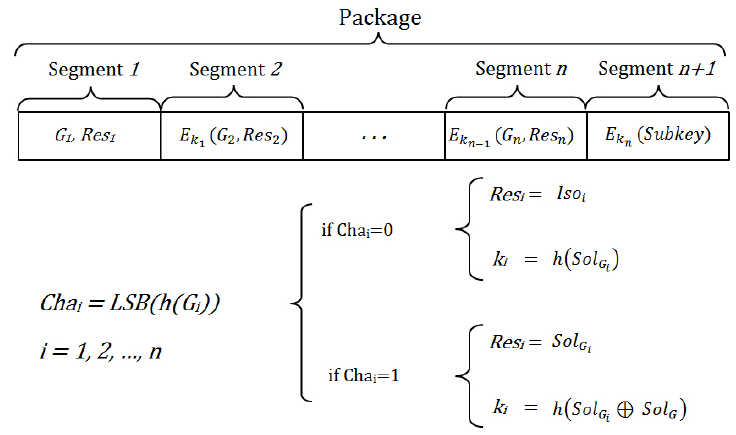
Figure 1. Components of sent